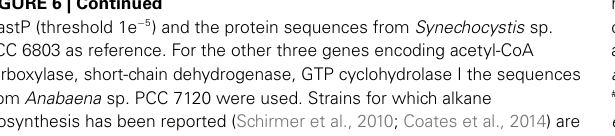
FIGURE 6 | Continued blastP (threshold 1e − 5 ) and the protein sequences from Synechocystis sp. PCC 6803 as reference. For the other three genes encoding acetyl-CoA carboxylase, short-chain dehydrogenase, GTP cyclohydrolase I the sequences from Anabaena sp. PCC 7120 were used. Strains for which alkane biosynthesis has been reported (Schirmer et al., 2010; Coates et al., 2014) are